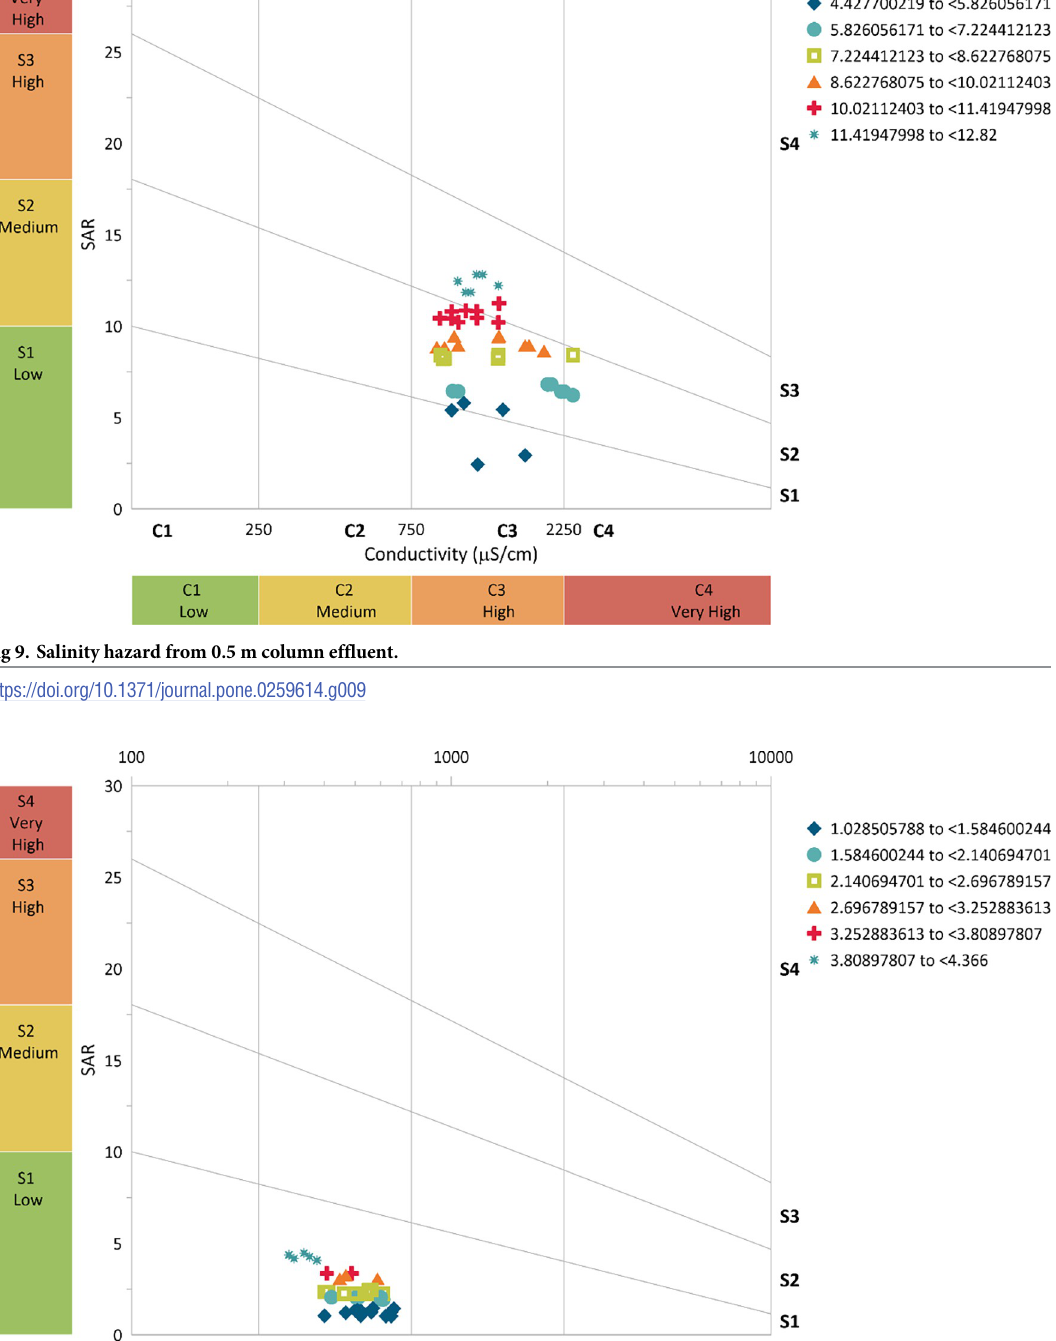
PLOS ONE | https://doi.org/10.1371/journal.pone.0259614 June 3,